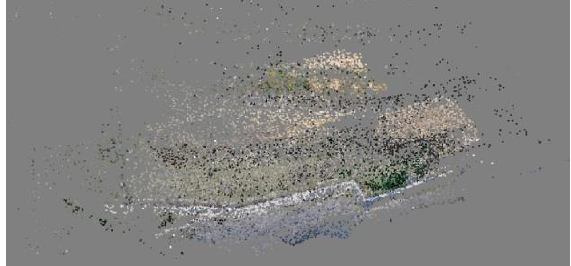
Figure 5. Sparse cloud of the area under